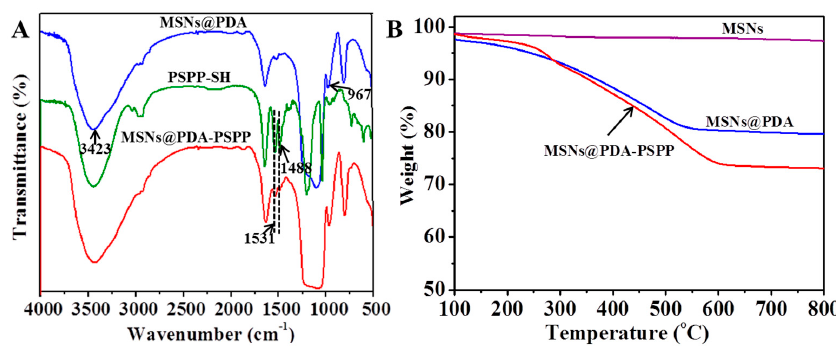
Figure 4. ( A ) Fourier transform infrared FTIR spectra of MSNs@PDA, PSPP-SH and MSNs@PDA- PSPP; ( B ) Thermogravimetric analysis (TGA) curves of MSNs, MSNs@PDA and MSNs@PDA-PSPP.